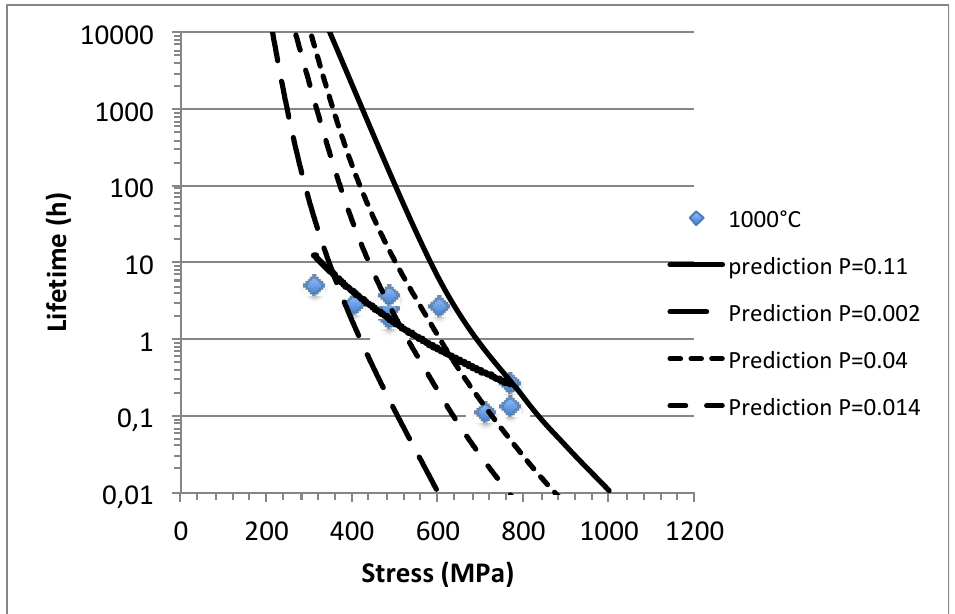
Figure 5. Static fatigue at 1000 °C on minicomposites: comparison with stress–rupture time curves for critical filaments. Table 3. Estimates of stress exponent p and constant A at different temperatures for